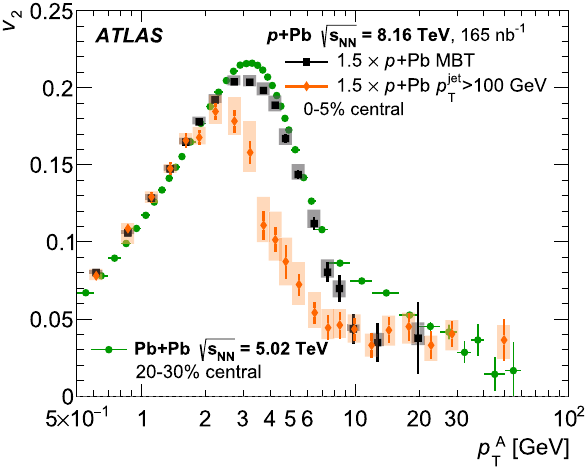
Fig. 9 Scaled p +Pb v 2 valuesplottedasafunctionoftheA-particle p T overlaid with v 2 from 20–30% central Pb+Pb data at [62]. Results from MBT and jet p T > 100 GeV p +Pb events are plotted as black squares and orange diamonds, respectively, and those from Pb+Pb are plotted as green circles. Statistical uncertainties are shown as narrow vertical lines on each point, and systematic uncertainties are presented as coloured boxes behind the